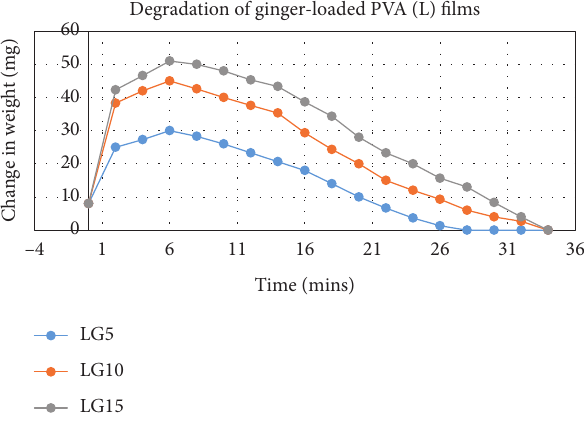
Figure 9: Degradation of ginger-loaded PVA (L)